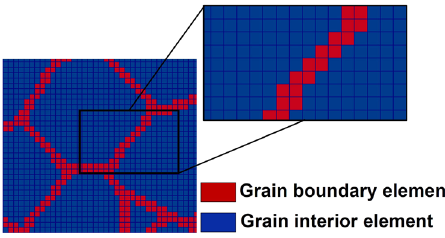
Fig. 3 Schematic illustration of grain interior and boundary elements. Red colored region represents grain boundary region while blue colored region represents grain interior